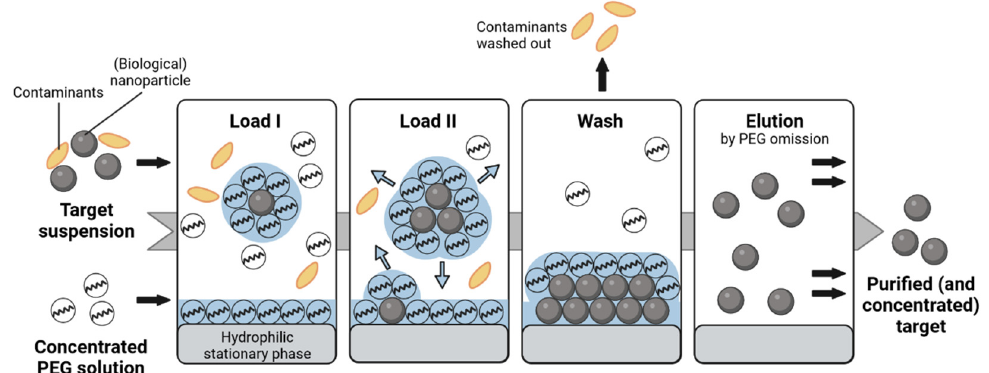
Figure 1. Overview of the working principle of the steric exclusion chromatography (SXC). The target (including impurities from production) is mixed with a concentrated PEG solution. The feed is loaded onto a hydrophilic stationary phase, e.g., cellulose membranes. A PEG-deficient zone (blue) covers the molecules and the stationary phase (load I), while the thickness of this zone is determined by the hydrodynamic diameter and the concentration of the PEG molecules. To reduce the PEG-deficient zones, targets associate/precipitate with each other as well as at the stationary phase (load II) [9,10]. The binding of the targets at the stationary phase allows for a wash-out of smaller contaminants (wash). The binding is reversable by reducing the PEG concentration (elution) so that a purified, concentrated sample can be eluted. The figure was adapted from Eilts et al. [20], and was prepared using biorender.com.